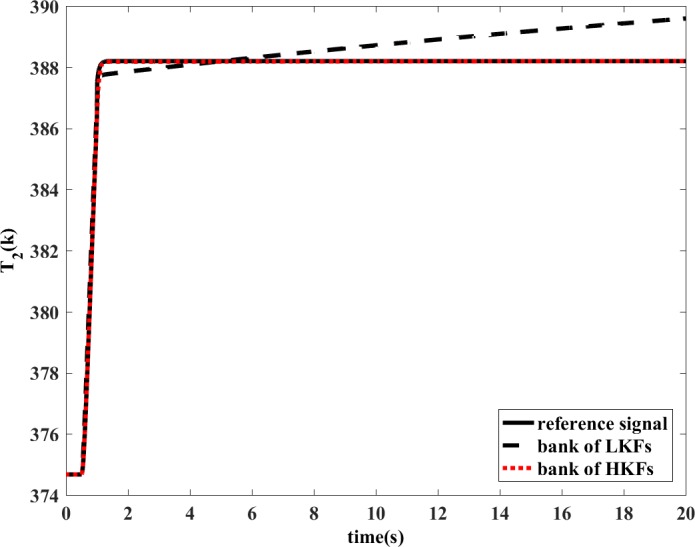
Comparison of the estimated value of T2.